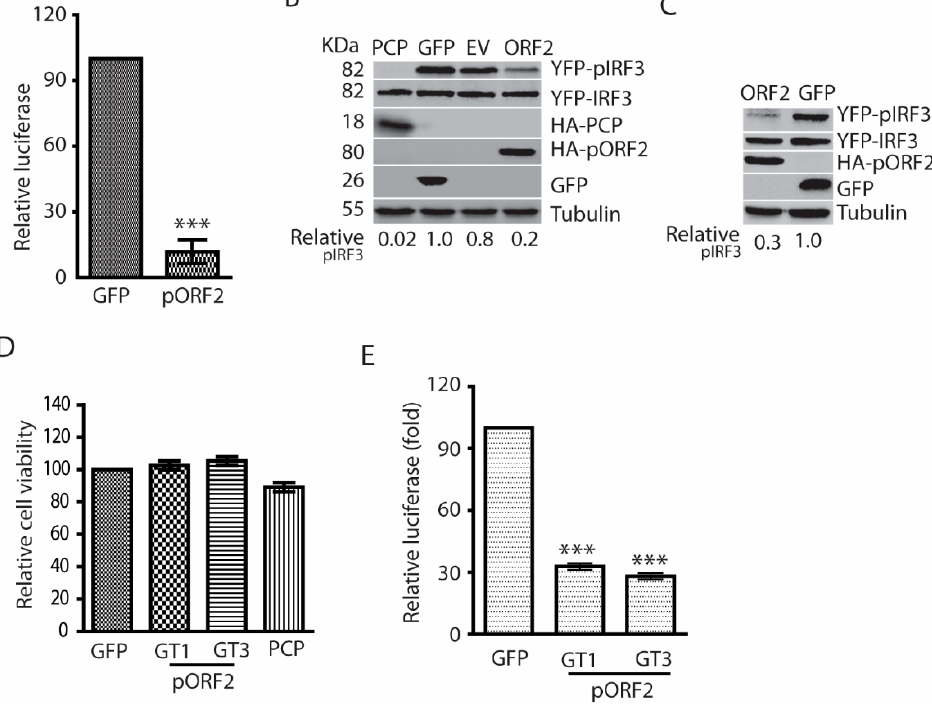
Figure 2. The capsid proteins of both genotype 1 and 3 HEV inhibit poly(I:C)-induced IFN production. ( A ) The capsid protein of Kernow (genotype 3, GT3) inhibits IFN- β reporter expression in HEK293T cells. The cells were transfected with plasmids of GT3 ORF2 and IFN- β reporter. At 36 h post-transfection (hpt), the cells were transfected with poly(I:C) at 1 µg/mL. The luciferase activity was detected after 24-h treatment. “***” denotes p < 0.001. ( B ) The capsid protein of HEV Kernow inhibits poly(I:C)-induced IRF3 phosphorylation. The 293T cells were co-transfected with plasmids of Kernow ORF2 and YFP-IRF3. Poly(I:C) treatment was conducted 24 h later. The cells were harvested for Western blotting (WB) after 8-h treatment. The PCP of HEV ORF1, GFP and empty vector (EV) were included as controls. WB with antibodies against phosphor-IRF3 (pIRF3), IRF3, HA tag, ORF2 product (pORF2), GFP and tubulin was done. The relative level of pIRF3 after normalization with tubulin is shown below the images. The molecular weights of the proteins are indicated on the left. ( C ) HEV Sar55 (genotype 1, GT1) ORF2 blocks IRF3 phosphorylation induced by poly(I:C). The GT1 ORF2 plasmid and YFP-IRF3 were co-transfected to HEK293T for pIRF3 test. Transfection and WB were conducted as described in “B” above. ( D ) Relative cell viability of HEK293T cells after transfection. The cells were transfected with plasmids of GFP, HEV ORF2, and PCP for 48 h before the cell viability assay. (E). HEV pORF2 downregulates Sendai virus-induced IFN- β expression in HEK293T cells. The cells were transfected with plasmids of HEV ORF2 (GT1 and GT3) and IFN- β reporter. At 24 hpt, the cells were infected with Sendai virus at an MOI of 5. Luciferase assay was done 24 h post-infection. “***” denotes p < 0.001.